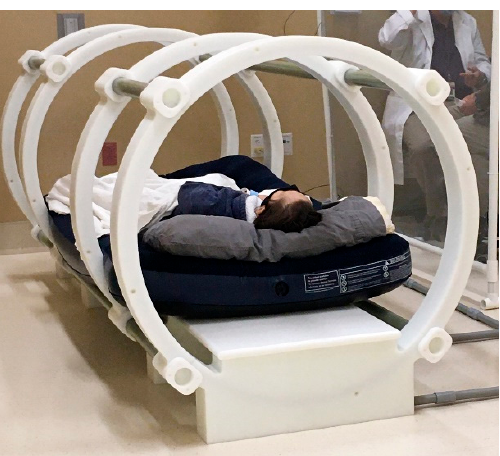
Figure 2. The photograph depicts the patient in the bore of the custom-built coaxial ring device used to deliver the uniform pulsed electric fields necessary for opening the VGSCs in TOL (The Phantom Laboratory, Salem, NY, USA).